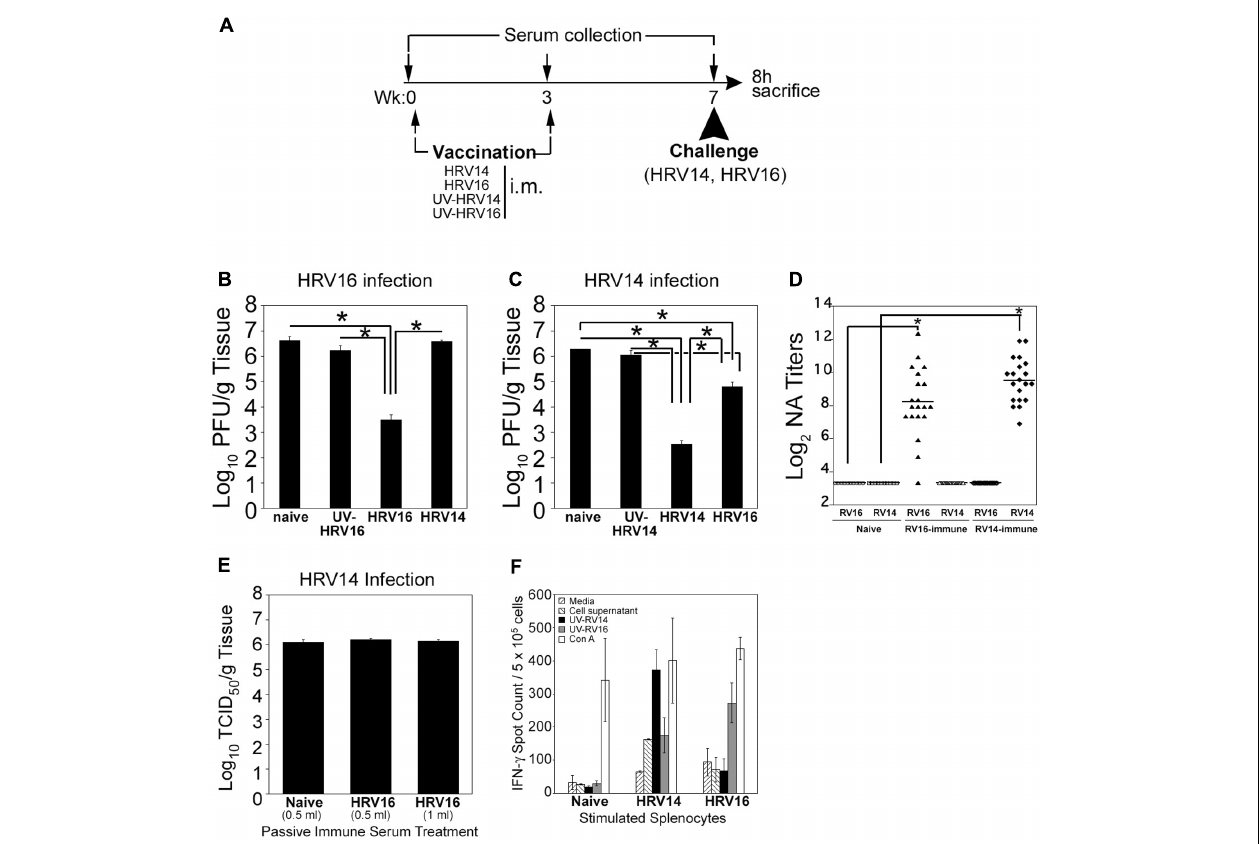
FIGURE 3 | Homologous and heterologous HRV protection measured in vivo . (A) Scheme of immunization, serum collection, and challenge for this experiment. Animals were either unimmunized (naïve), immunized i.m. with UV- HRV14 or UV-HRV16, or immunized i.m. with live HRV14 or HRV16 (10 6 PFU/100 µ l). Three weeks after the initial immunization, animals were boosted with the same immunogen as indicated. At week 7, half of the animals in each group were challenged i.n. with HRV14 (10 6 PFU/100 µ l) and half with HRV16 (10 7 PFU/100 µ l), and all were euthanized 8 h later to determine lung viral titers. Lung viral titers following (B) HRV16 and (C) HRV14 infection are shown. n = 5 animals/group, data representative of two independent experiments. All data differences between different immunization groups with same infection were assessed by one-way ANOVA and individual differences were identified by Bonferroni post hoc test. (D) Homologous and heterologous serum NA titer of HRV14- or HRV16-immunized sera. NA titers were determined as described in the Materials and Methods section. The sera were assayed in duplicate and NA titer is expressed as Log 2 geometric mean ± SEM, n = 10–20 sera/group. A NA titer of 3.3 ± 0.0 is the limit of detection of the assay. (E) Passive transfer of HRV16 hyper immune serum does not protect animals from HRV14 challenge. Animals were treated intraperitoneally with naïve serum (0.5 ml) or serum from animals immunized i.m. with HRV16 (0.5 or 1 ml). The following day, animals were challenged i.n. with 10 6 PFU (100 µ l/rat) of HRV14 and euthanized 8 h later to determine lung viral titers. n = 5 per group. (F) IFN- γ ELISPOT with splenocytes of naïve, HRV14-, and HRV16-immunized cotton rats after in vitro stimulation with control media, uninfected HeLa OH cell supernatant, homologous or heterologous UV-inactivated viruses, and Con A. Cotton rats were either unimmunized (naïve), immunized i.m. with live HRV14 or HRV16 (10 6 PFU/100 µ l). Three weeks after the initial immunization, animals were boosted with the same immunogen as indicated. At week 7, spleens were harvested and IFN- γ producing cells were estimated by ELISPOT assay as described in Section Materials and Methods. n = 3–5